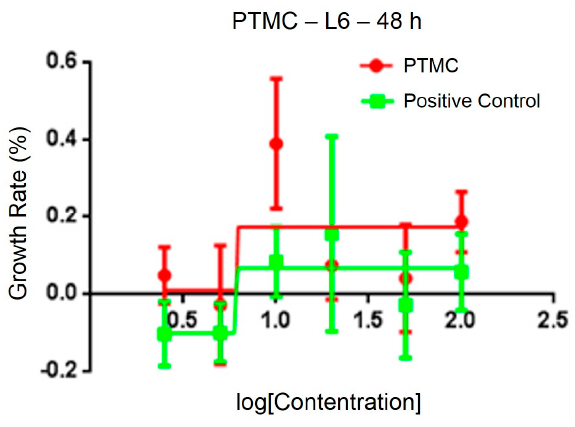
Figure 6. Cytotoxicity of the medical adhesive determined by 3-(4,5-dimethylthiazol-2-yl)-2,5-diphenyl tetrazolium bromide (MTT).